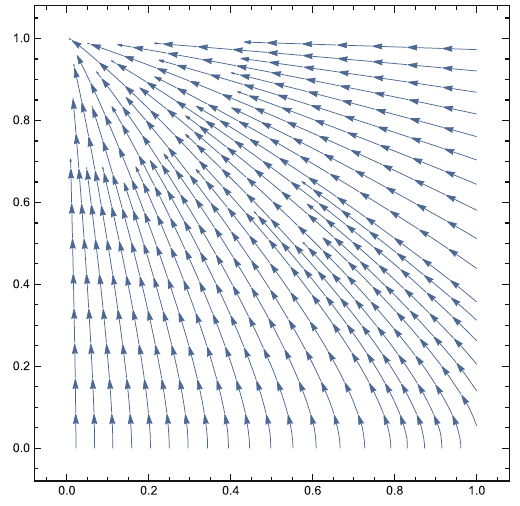
Fig. 2 Phase space diagram for the dynamical system (16), (17), (19) in the space of variables (cid:8) b ,(cid:8) (cid:2) for n < 1 and (cid:8) r = 10 − 4 . The unique attractor is the de Sitter point A